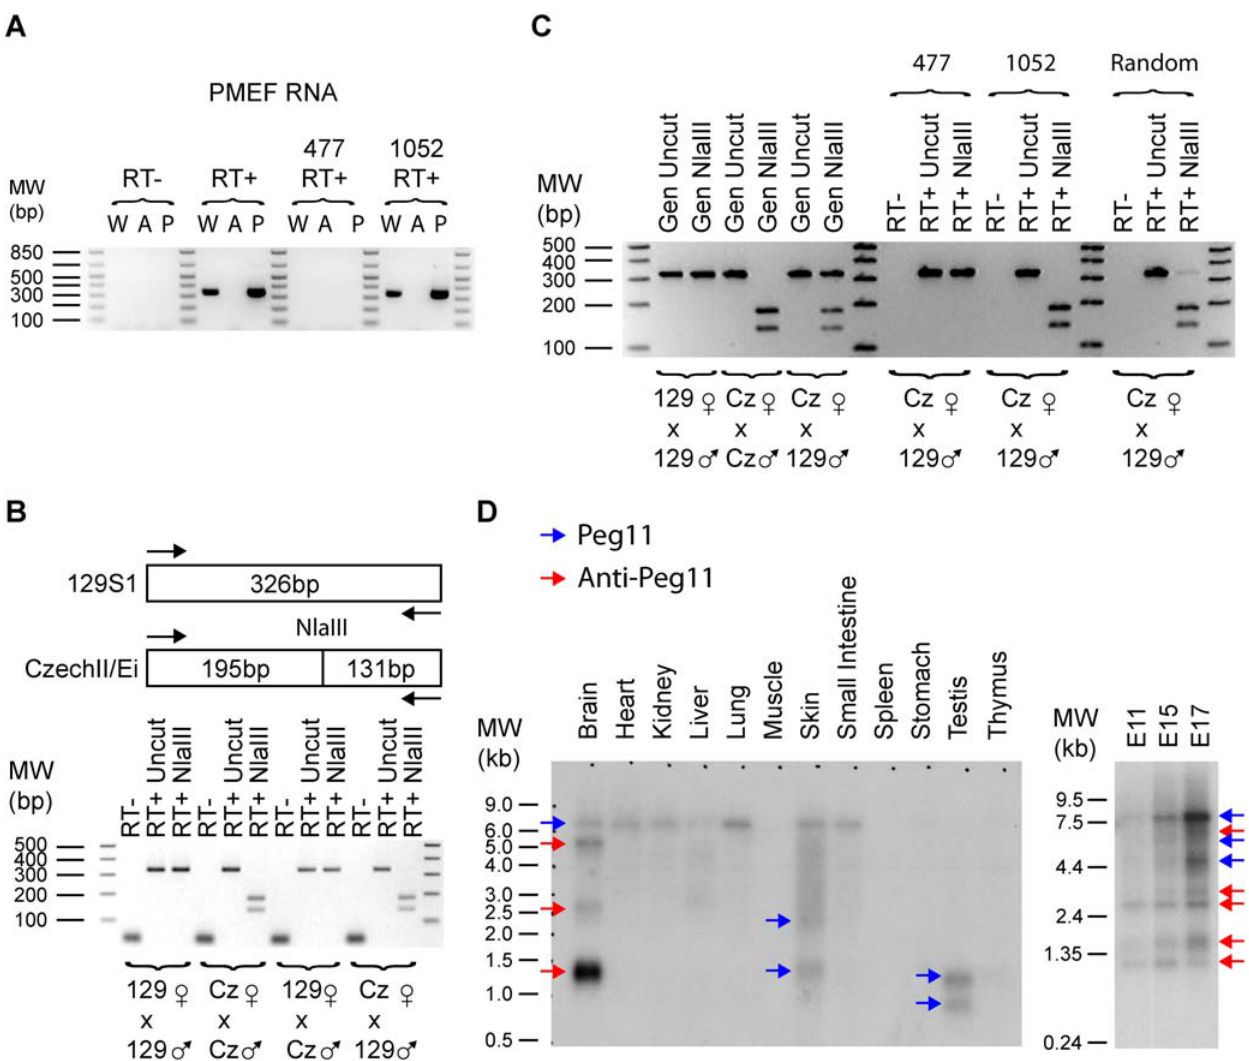
Figure 5. Imprinting and expression analysis of mouse Peg11 and anti-Peg11 . (A) RT-PCR was performed on RNA derived from wild-type {W}, Androgenetic {A} and Parthenogenetic {P} PMEF cell lines. RT reactions were performed with either random hexamers or the strand-specific primers for Peg11 ‘‘477’’ or Anti-Peg11 ‘‘1052’’. For PCR, Anti-Peg11 522Up/847Dn primers were used. These results demonstrate that in PMEFs Anti-Peg11 is expressed but not Peg11 . (B) An NlaIII restriction site polymorphism between 129S1 and CzechII/Ei was utilized to demonstrate that Anti-Peg11 is maternally expressed in PMEFs. (C) As in panel A, three RT reactions were performed with the same PCR primers but on adult brain RNA derived from a mouse with a CzechII/Ei mother and 129S1 father. These results demonstrate that Anti-Peg11 and Peg11 are both expressed, although Anti-Peg11 is more abundant in mouse brain. Peg11 was paternally expressed, while Anti-Peg11 was maternally expressed. PCR on genomic DNA (Gen) revealed that the primers did not preferentially amplify either the 129S1 or CzechII/Ei alleles. (D) Northern for Peg11 and Anti-Peg11 using a double stranded DNA probe corresponding to Anti-Peg11 477-1052. Blue arrows indicate the position of Peg11 transcripts, while red arrows correspond to Anti-Peg11 . This annotation was possible as the Northern was repeated with single stranded probes for both Peg11 and Anti-Peg11 (data not